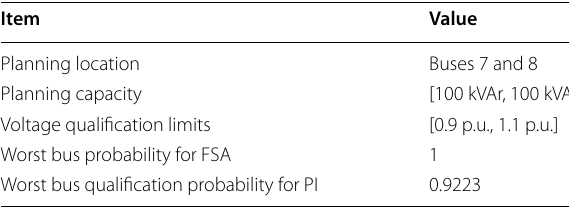
Table 13 Optimum planning results